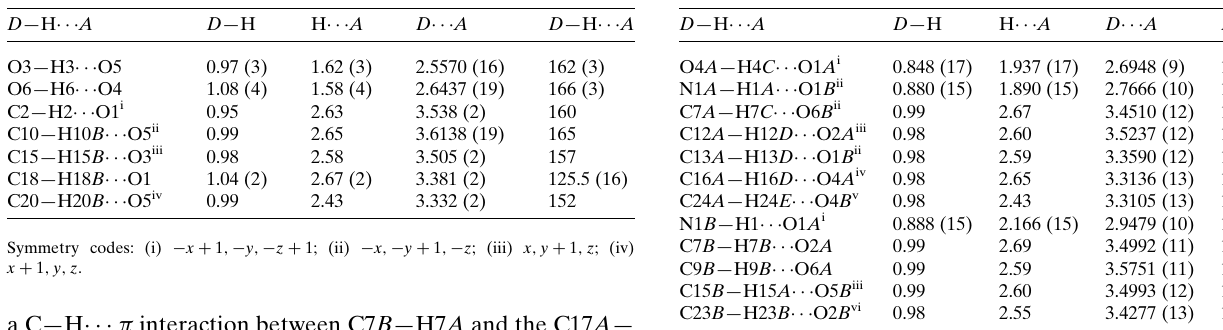
Table 2 Hydrogen-bond geometry (A˚ , (cid:3) ) for